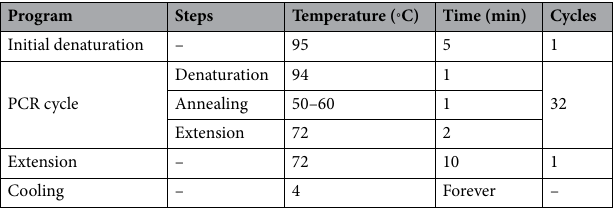
Table 1. PCR program for amplification of AChE gene with specific primer.